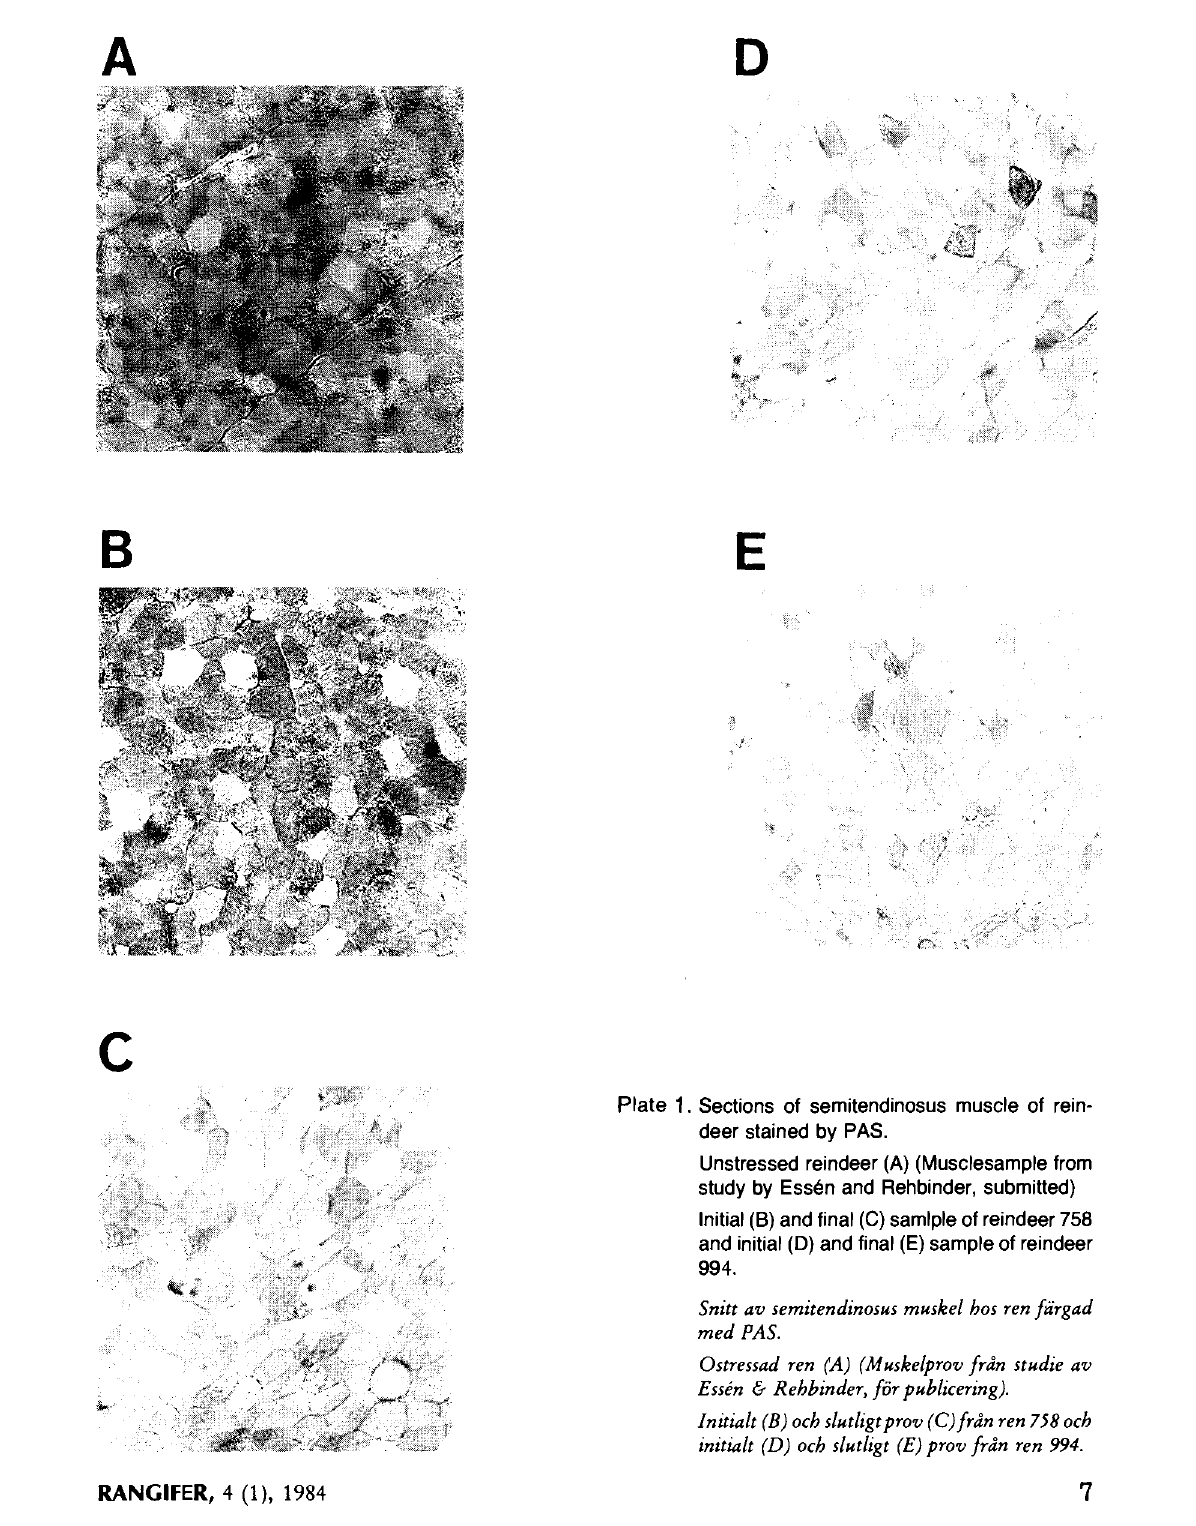
Plate 1. Sections of semitendinosus muscle of rein deer stained by